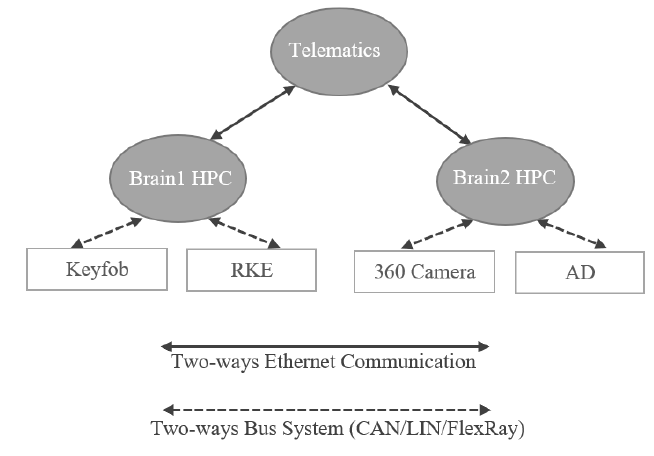
Figure 14. Use Case Representation of Two-Brain Architecture. The two-brain architecture has been modelled using Medini Analyze and is shown in Figure 15.